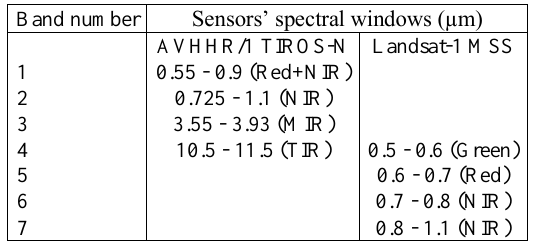
Table 1 . Spectral wavebands of the AVHRR/1 TIROS-N